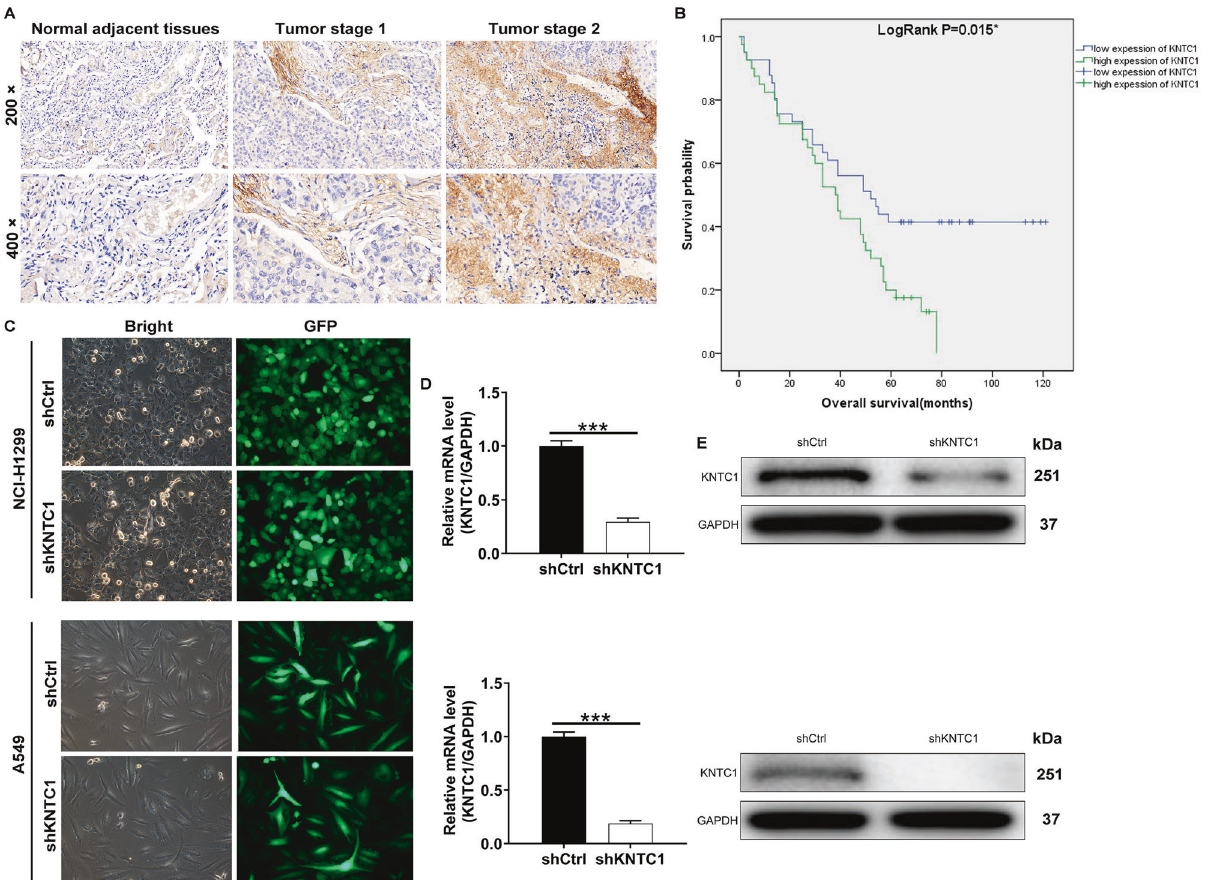
expression and prognosis of NSCLC patients. C The transfection ef fi ciencies of shKNTC1 in NSCLC cell lines were evaluated by observing the fl uorescence of GFP. Magni fi cation times: ×200. D The KNTC1 mRNA expression in NSCLC cell lines after transfection was analyzed by qRT-PCR. E The expression of KNTC1 protein in NSCLC cell lines after transfection was detected by western blot. *** P <